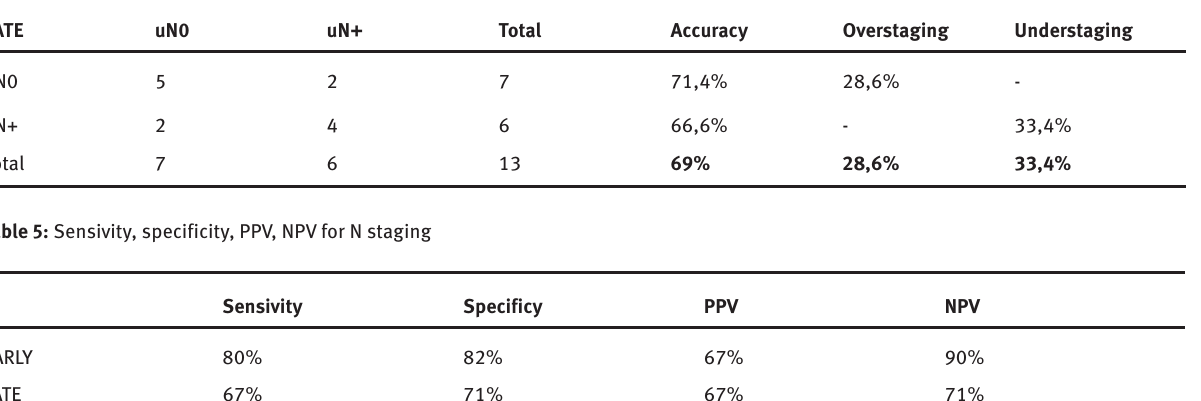
Table 4 : Accuracy, overstaging and substaging risk for uN stages – Late group